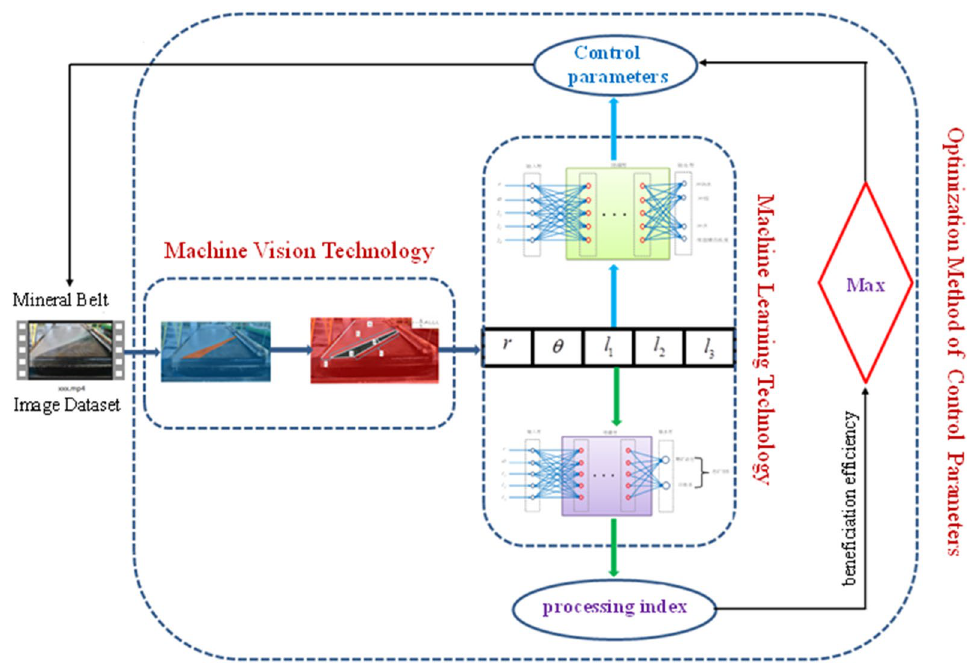
Figure 12. Research on optimization of shaking table control parameters combining machine vision and machine learning technology.